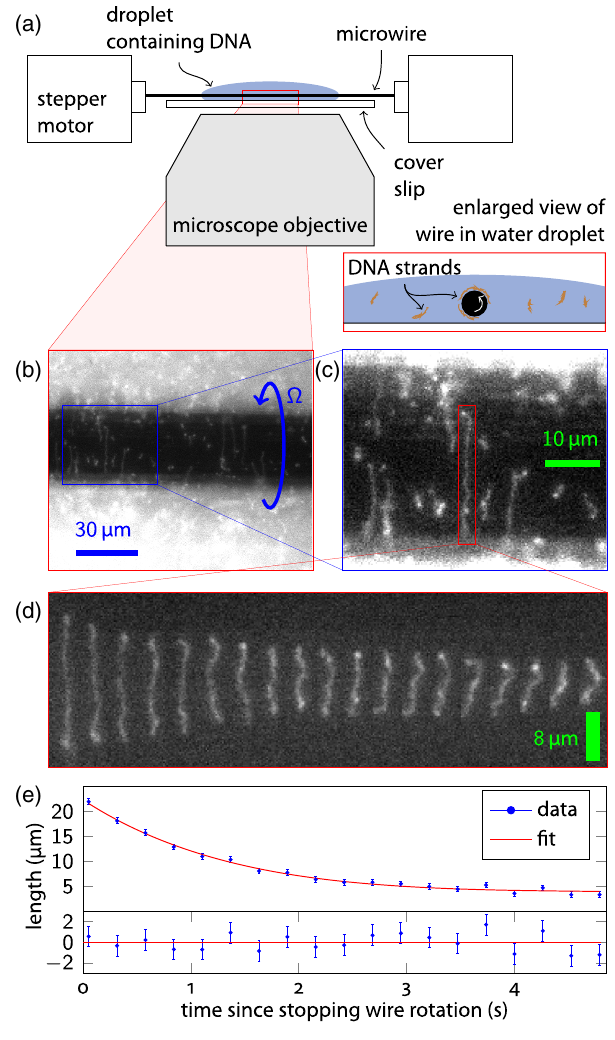
FIG. 2. The apparatus for untethered strands. (a) Schematic representation of the apparatus, described in detail in the text. (b) Sample image of a 50 - μ m-diameter tungsten wire (dark horizontal line) rotating in a dilute solution of T4-phage DNA (166 kbp). The contour length of YOYO-1 stained T4-DNA is ð 65 (cid:3) 2 Þ μ m. Strands of DNA are drawn towards the wire and elongated by the shear flow. (c) Image of the microwire 1s after it has stopped rotating: DNA strands have begun to relax to more entropic states. (d) Conformational relaxation of a single DNA strand in the period of time immediately after the microwire has stopped rotating (see Movie 1 in Ref. [16]). (e) Quantitative measurements of the extension of a single DNA strand during relaxation, along with the fit and associated studentized residuals, used to determine the fully extended length of the polymer ( t ¼ 0 ).